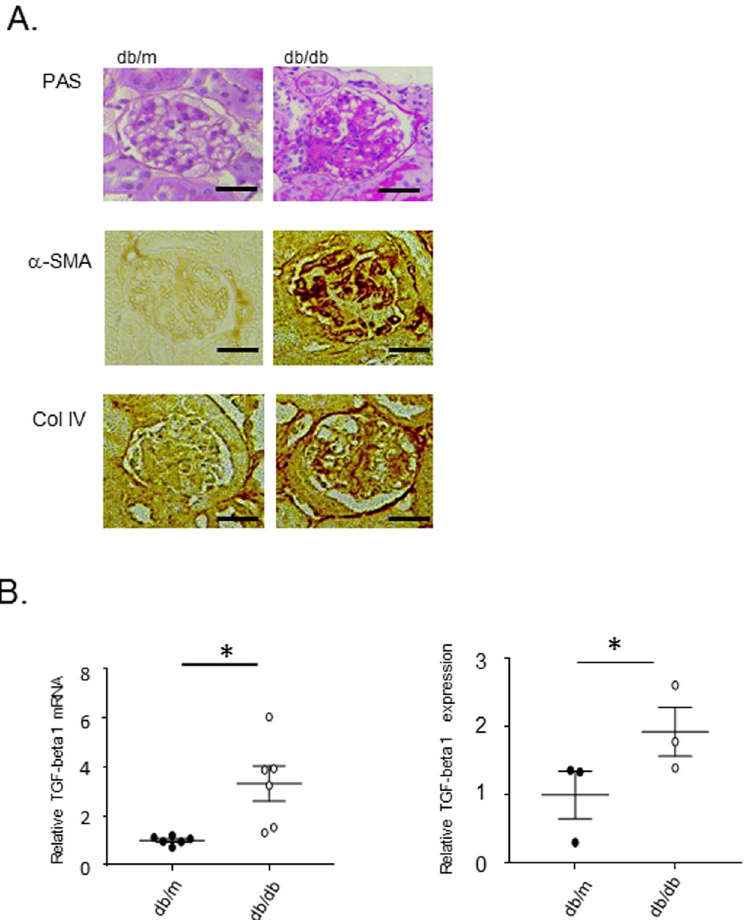
Figure 1. Mesangial cell fibrosis and upregulation of TGFB1 expression in db/db mice. ( A ) PAS staining and representative images of immunostaining of α− smooth muscle actin ( α -SMA) and type IV collagen (Col IV) in glomeruli from 15-week-old db/m , db/db , Mesangial cell fibrosis and the expression of α -SMA and Col IV are significantly increased in db/db mice compared to db/m mice. ( B ) Real-time PCR of Tgfb1 mRNA (normalized to Gapdh ) and the results of immunoblotting of TGFB1 (normalized to beta-actin) in whole kidneys of 15-week-old db/m , db/db mice. The expression of Tgfb1 mRNA and TGFB1 protein in db/db mice significantly higher than that in db/m mice. Data represent the mean ± SEM. n = 6. Filled circles: db/m mice; open circles: db/db mice. Original gel image of western blot analysis are presented in Supplemental Fig.